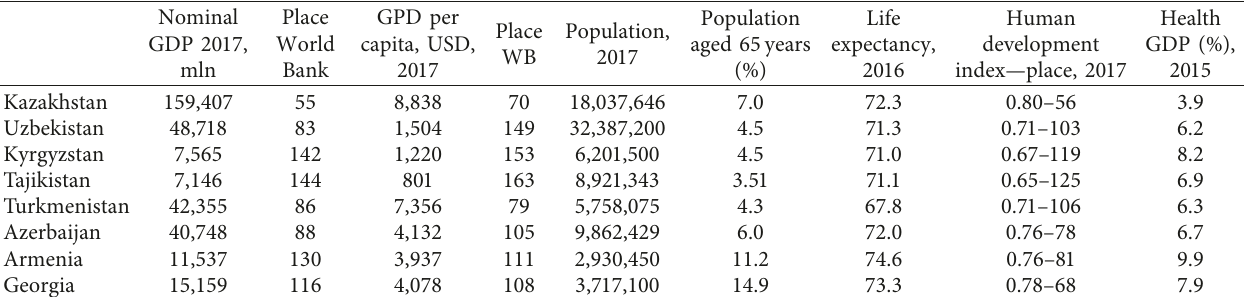
Figure 1: Central Asian and Transcaucasian countries on the world map. Table 1: Central Asian and Transcaucasian country profiles (https://knoema.com/atlas/ranks, WHO,